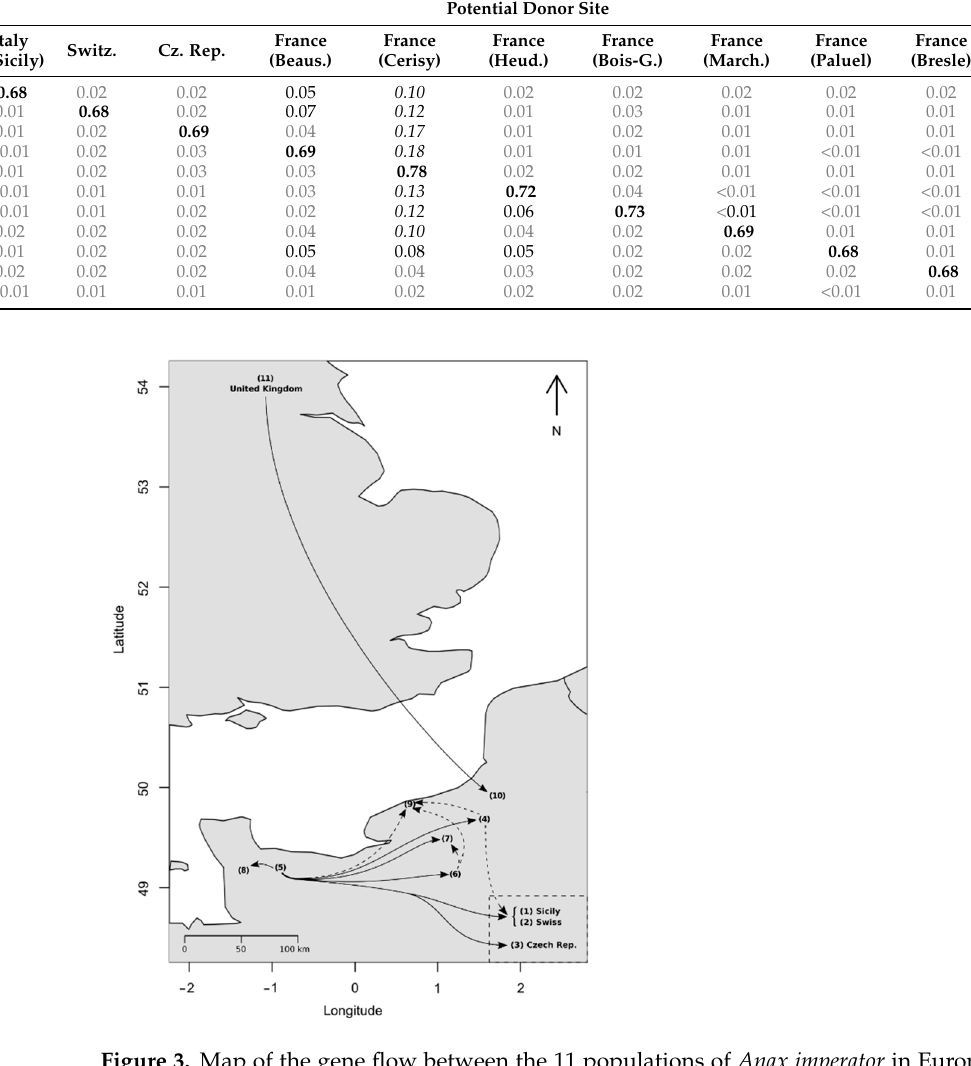
Figure 3. Map of the gene flow between the 11 populations of Anax imperator in Europe. Arrows indicate gene flow between pairs of sites with ≥ 5% exchange (dashed lines) and ≥ 10% exchange (solid lines). Numbers in parentheses are numbers assigned to populations in Table 1.